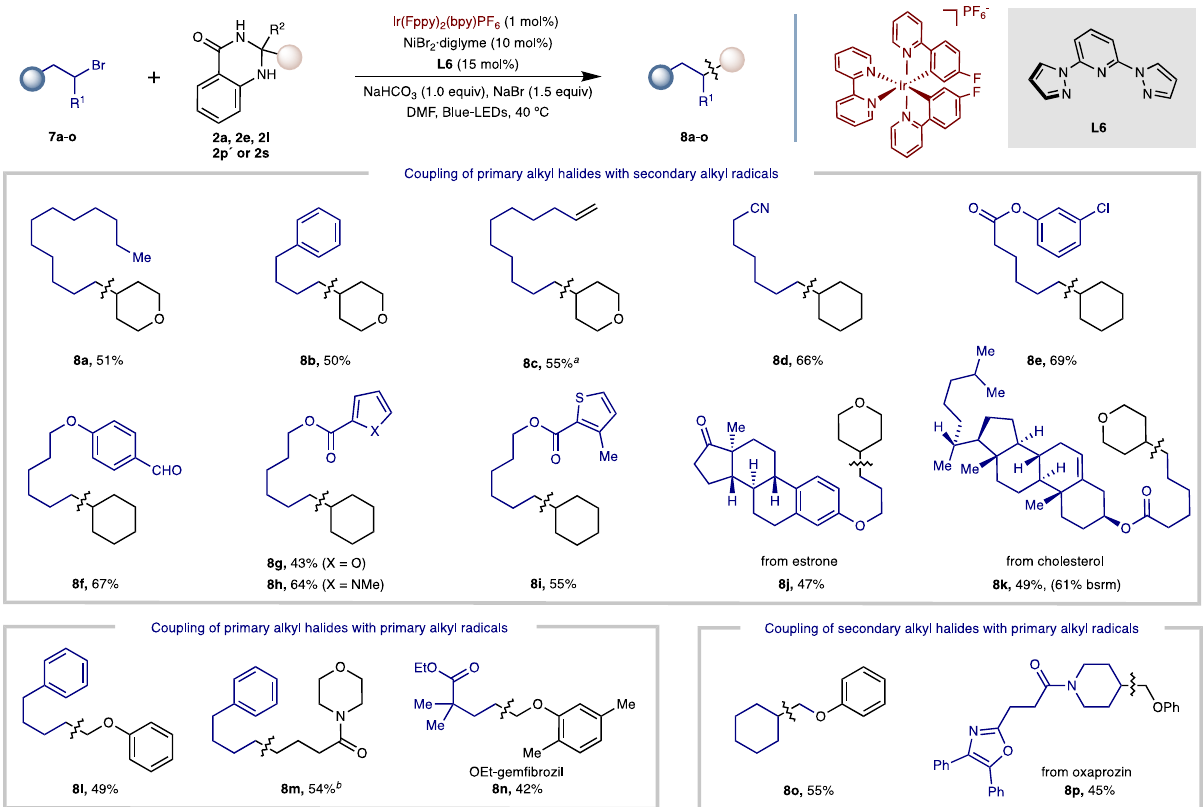
Fig. 4 Scope of sp 3 alkylation. Alkyl bromide (0.20 mmol), dihydroquinazolinone (0.30 mmol), NiBr 2 ·diglyme (10 mol%), L6 (15 mol%), NaBr (1.5 eq.), NaHCO 3 (1.0 eq.) in DMF (0.1 M) at 40 °C for 24 h. Isolated yields, average of two independent runs. Unless stated otherwise, R 2 = Me in the ketone derivative. a DMF (0.2 M). b R 2 = Ph in the ketone (Fig. 7). Oxidative single-electron transfer from dihydroquinazo-